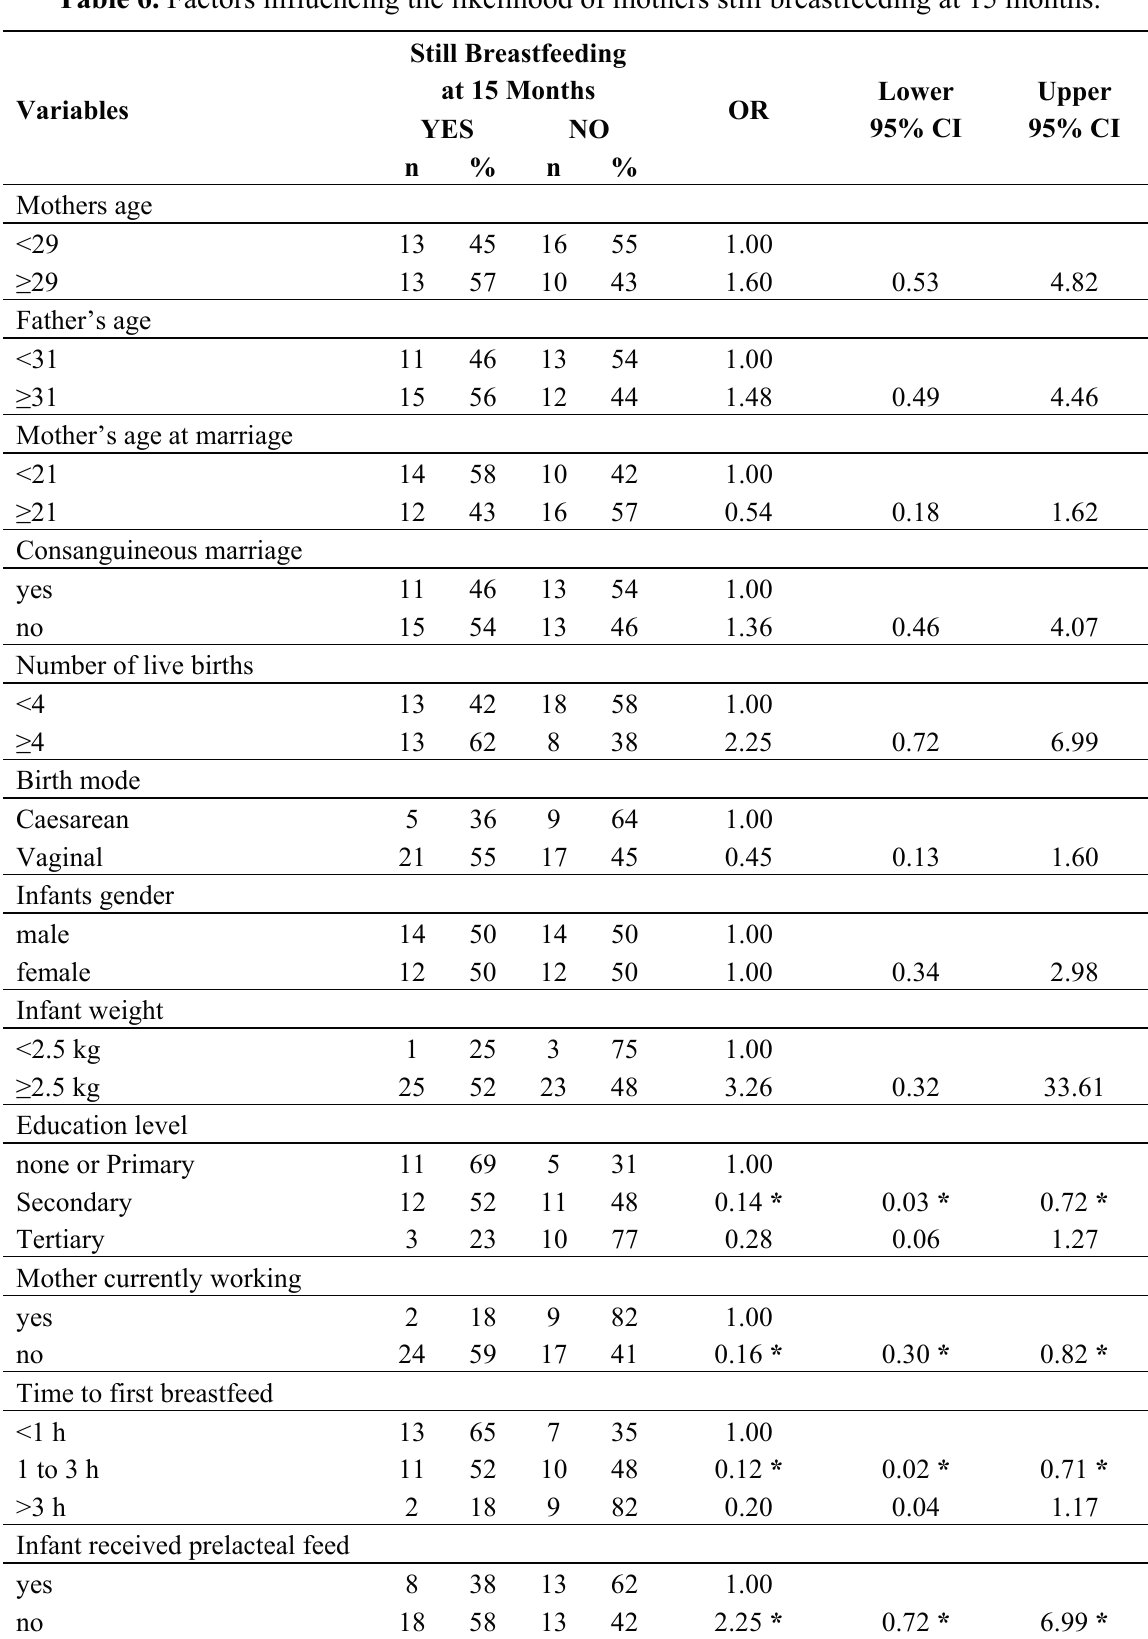
Table 6. Factors influencing the likelihood of mothers still breastfeeding at 15 months. Still Variables